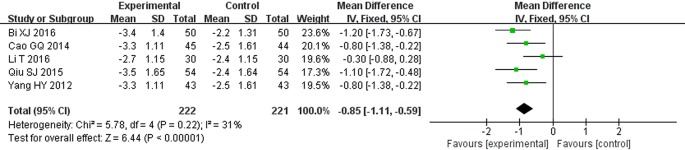
Meta-analysis for comparison of urinary immunoglobulin G (IgG) levels between the experimental and control groups.